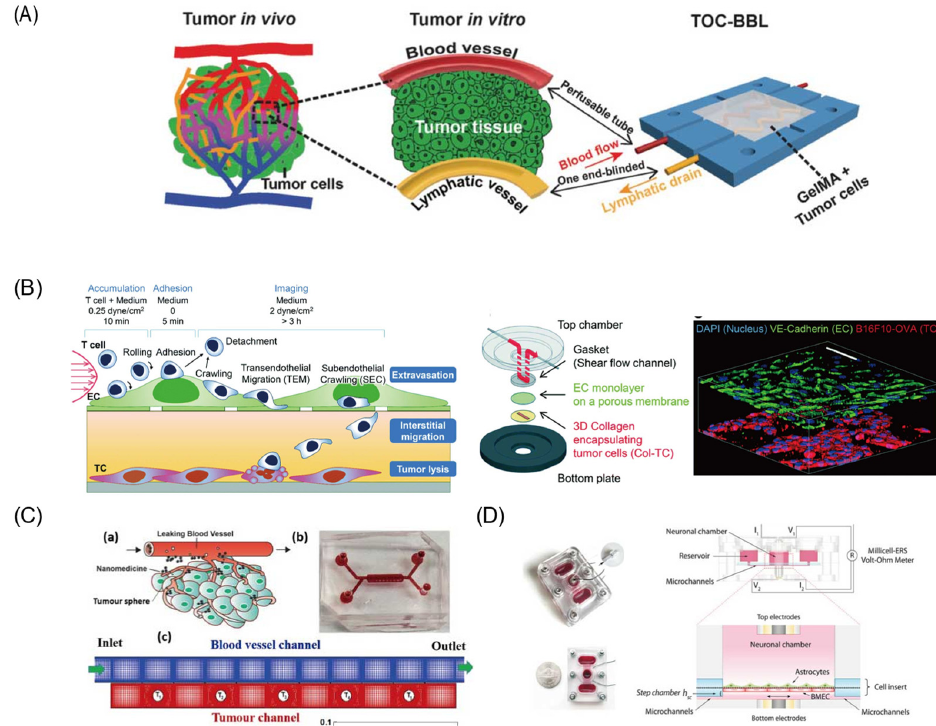
Figure 5. Different kinds of organs-on-a-chip. ( A ) The biomimetic in vitro model of tumor-on-a-chip with bio-printed blood and lymphatic vessel pair. ( B ) Multilayered blood vessel/tumor tissue chip (MBTC). ( C ) The schematic for the system of tumor tissue and blood vessels (a) schematic (b) picture of microfluidic device. (c) Computational mesh ( D ) The assembled microfluidic human model of BBB and its side view showing the fluid pathway. Reprinted and adapted with permission from: ( A ) Cao et al. [101], ( B ) Lee et al. [114], ( C ) Li et al. [100], and ( D ) Wang et al. [121].